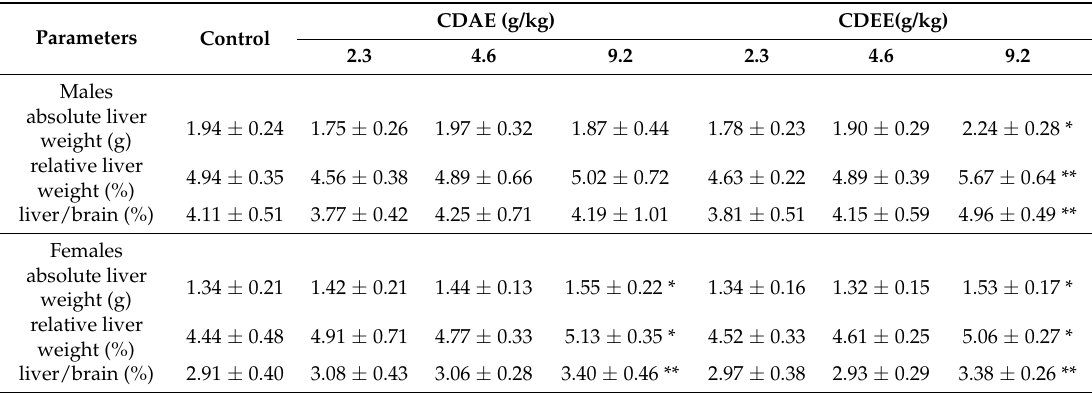
Table 3. Effects of oral administration of CDAE and CDEE on liver-related indexes in